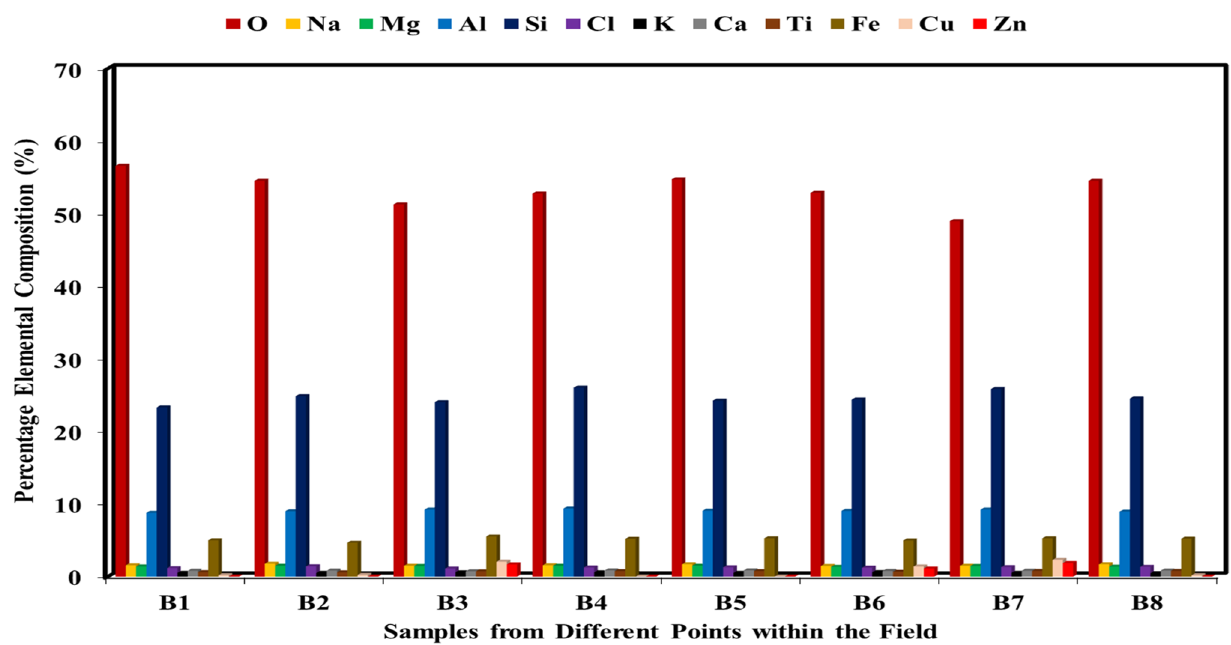
Fig. 4 Elemental compositions of samples from various locations Table 1 Na + /Ca 2+ ratio